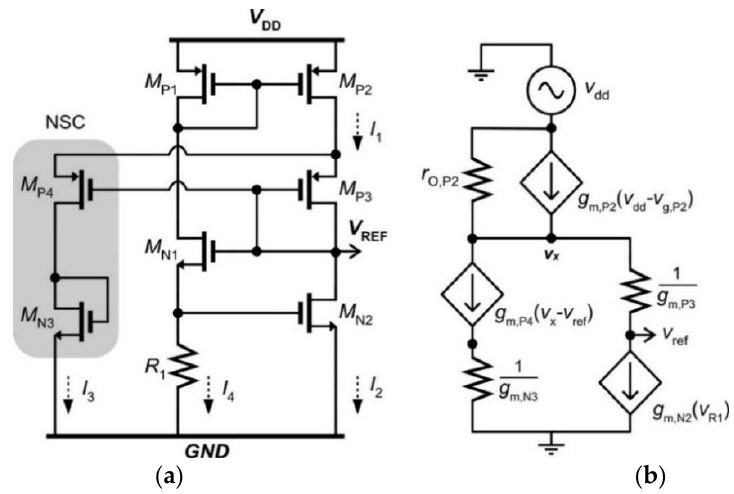
Figure 2. ( a ) Proposed reference circuit and ( b ) its small-signal equivalent